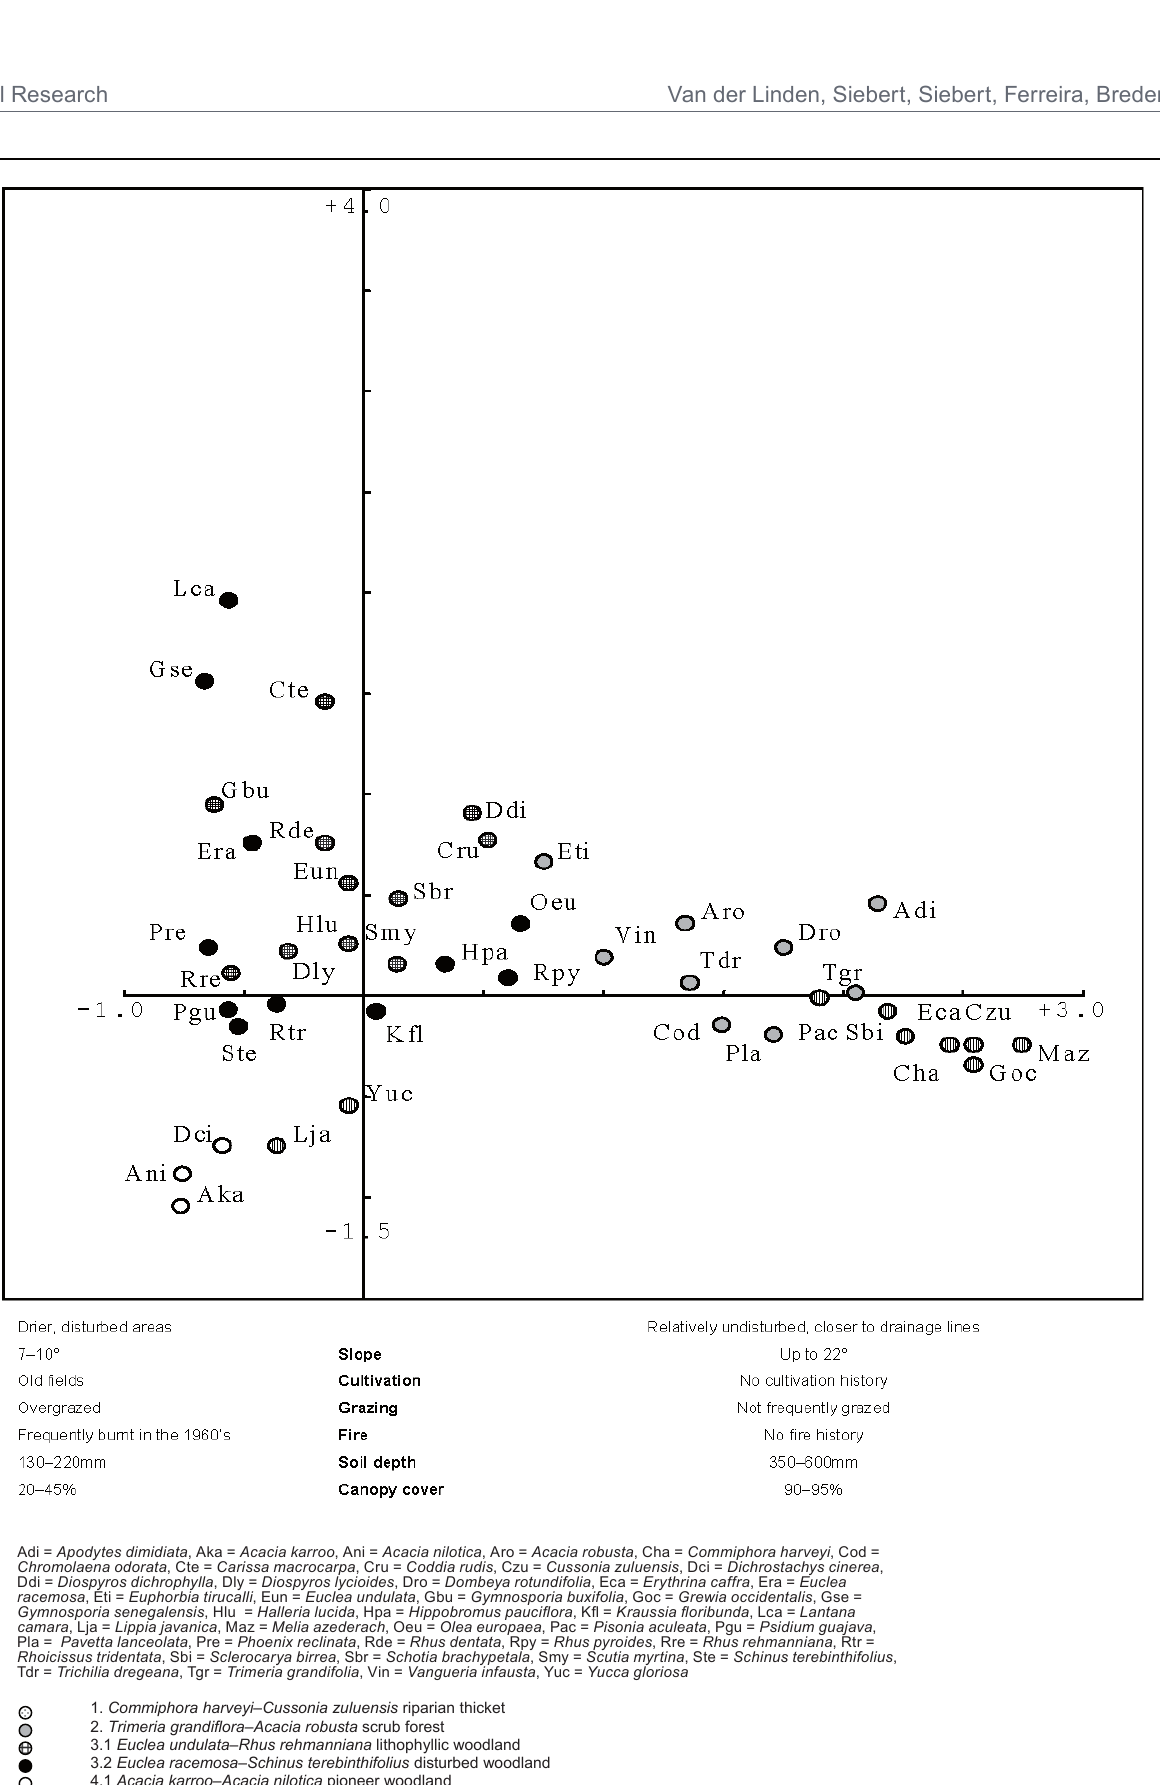
1. Commiphora harveyi–Cussonia zuluensis riparian thicket 2. Trimeria grandiflora–Acacia robusta scrub